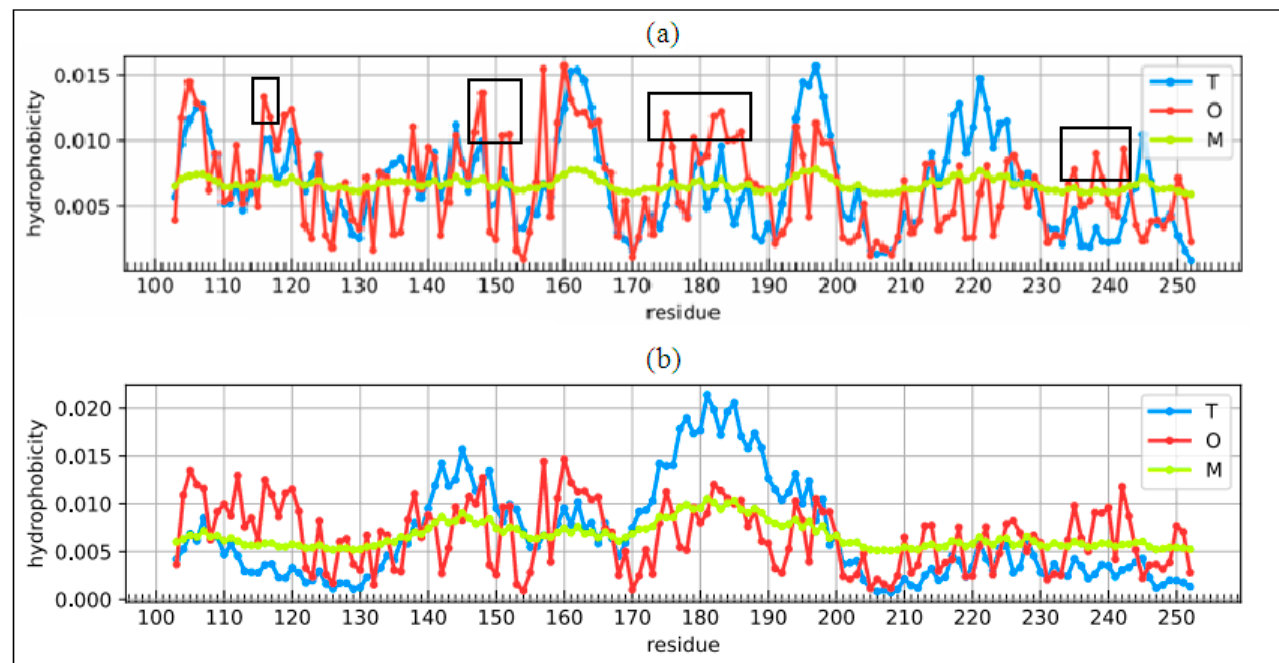
Figure 10. Characteristics of dom2 domain—( a )—profiles T, O, and M identified in dom2. The residues engaged in the P–P interaction are designated. ( b )—profiles T, O, and M in domain dom2 after complex formation.